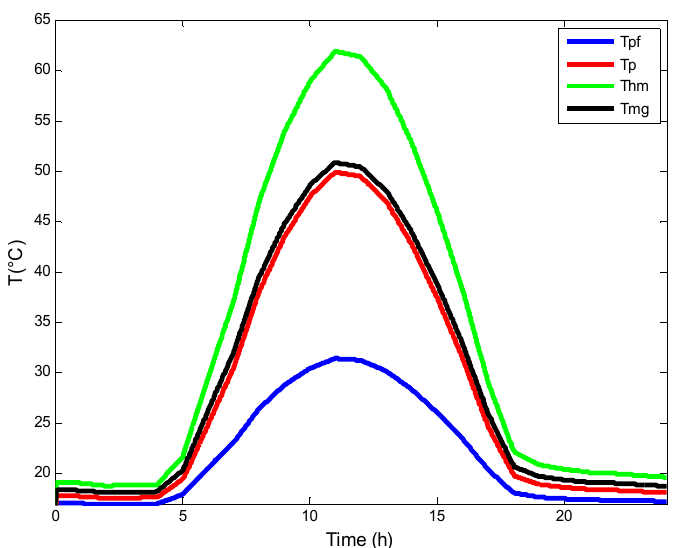
Figure 7. Variation of AGMD operating temperatures with time.